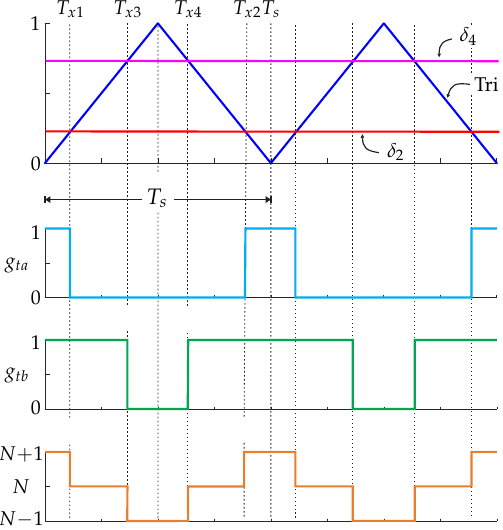
Figure 5. Dwell times of voltage levels, proposed SAM